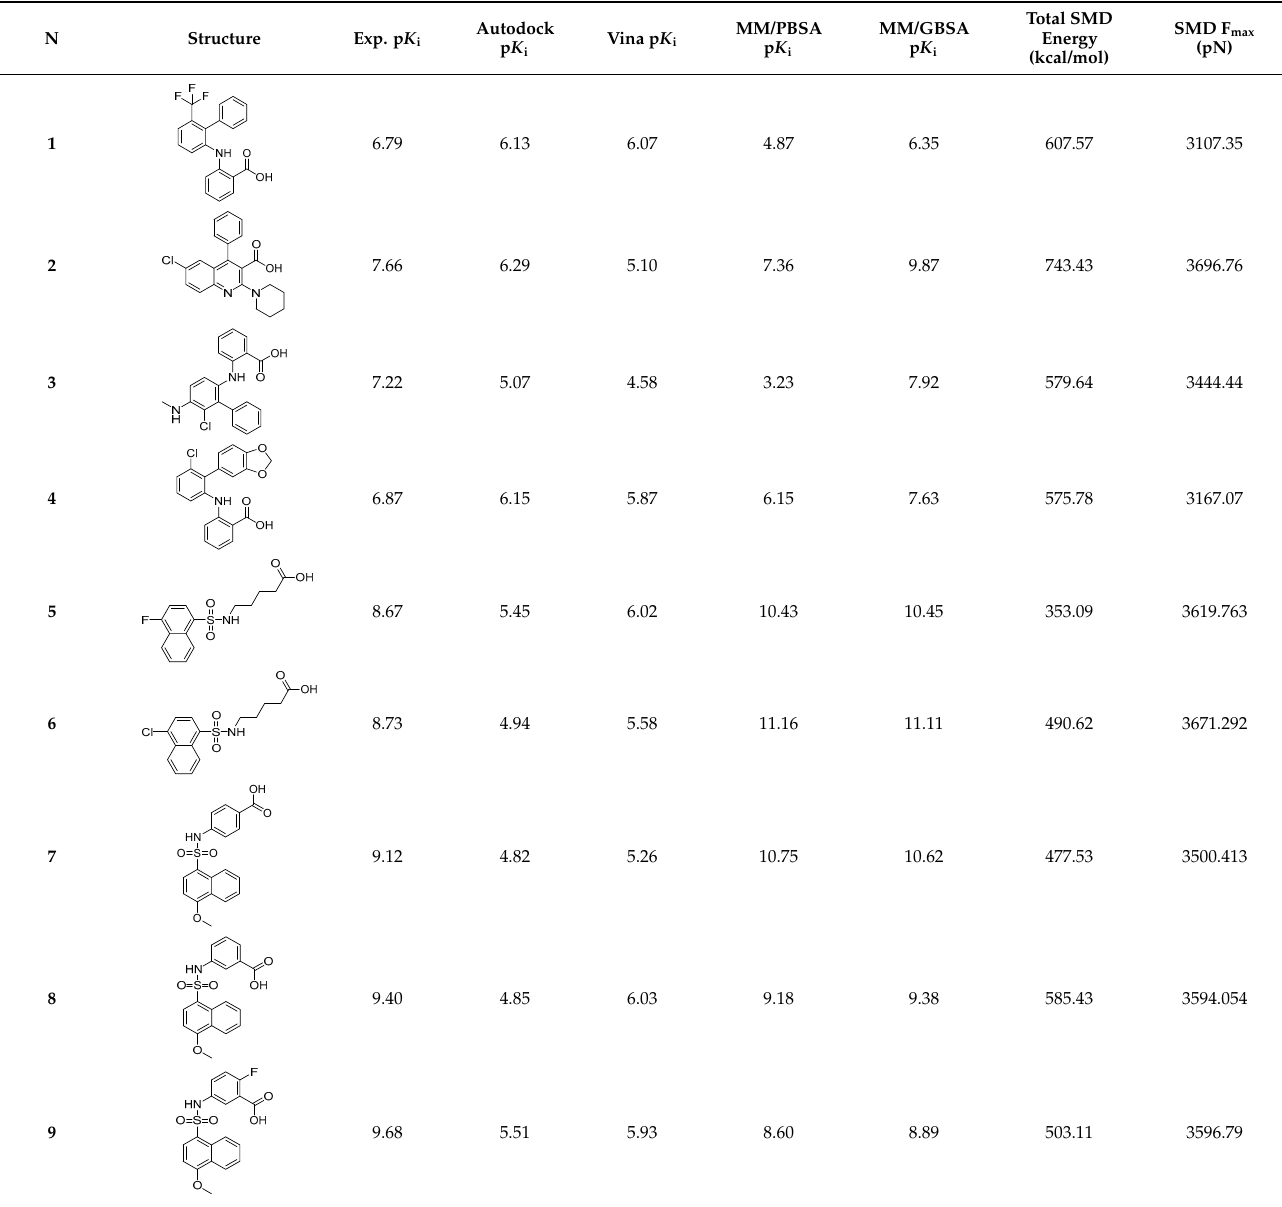
Figure 2 states the total energies and the max force (F max ) obtained from each SMD experiment. Simulations were carried out in triplicate with double-blind conditions using different hardware systems to ensure the homogeneity and repeatability of the experiment. The MMPB(GB)SA and the SMD simulations were superior overall at linearly corre- lating the experimental data (employing relative and not absolute binding value) for the studied molecules compared to the scoring functions of Autodock and Vina, which were the least able to correlate the calculated free energy with the experimental data (Tables 2–4, Figures 3 and